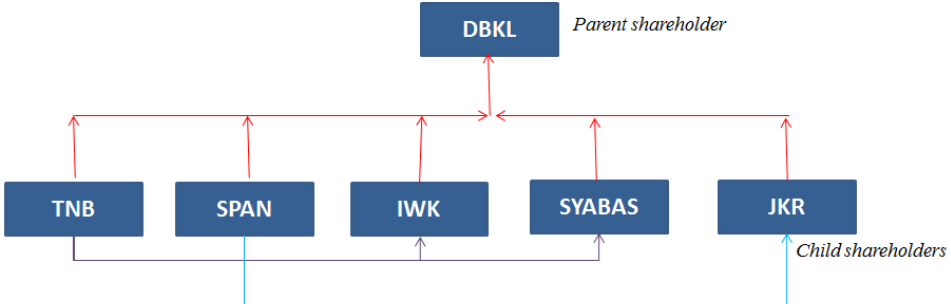
Figure 16: Example stakeholder hierarchy in sharing the aim/collaborative system in the proposed DBKL DCP